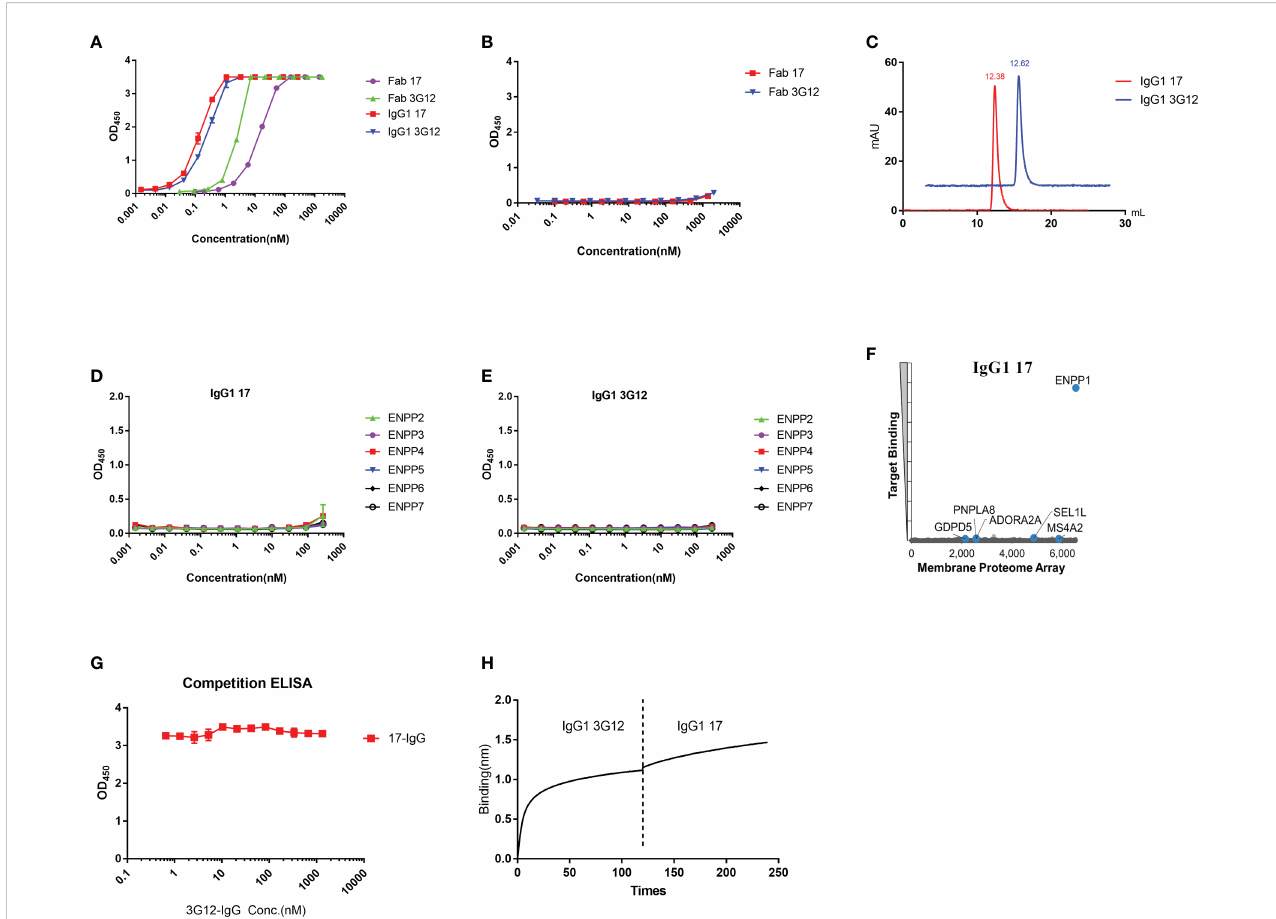
FIGURE 1 Speci fi city of Fab/IgG1 with recombinant human ENPP1 and human membrane proteins. (A) , Fab 17, Fab 3G12, IgG1 17 and IgG1 3G12 binding to recombinant human ENPP1 measured by ELISA. Experiments were performed in duplicate. (B) , Binding of Fab 17 and 3G12 to BSA measured by ELISA. (C) , Aggregation evaluation of IgG1 17 and IgG1 3G12 measured by SEC. (D) , Binding of IgG1 17 to ENPP other members measured by ELISA. (E) , Binding of IgG1 3G12 to ENPP other members measured by ELISA. (F) , MPA screen with over 6,000 human membrane proteins. (G) , Competitive ELISA of IgG1 17 with serial diluted IgG1 3G12 for binding to ENPP1. (H) , Competitive BLItz of IgG1 3G12 with IgG1 17 at 200nM for binding to